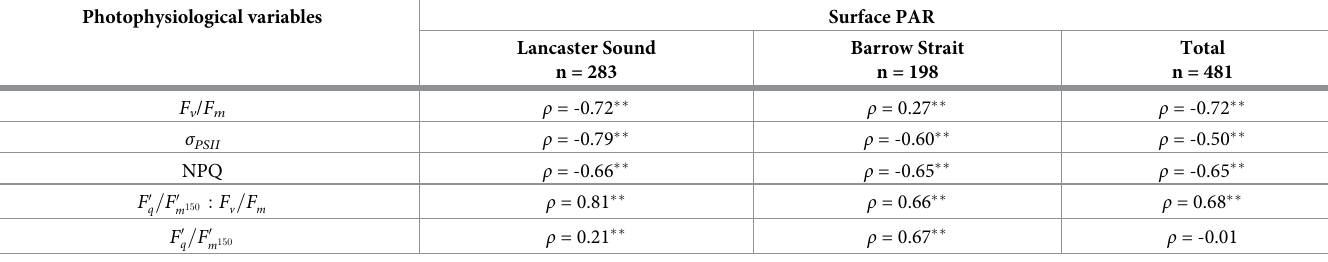
Table 2. Correlation of underway photophysiological variables and surface PAR.